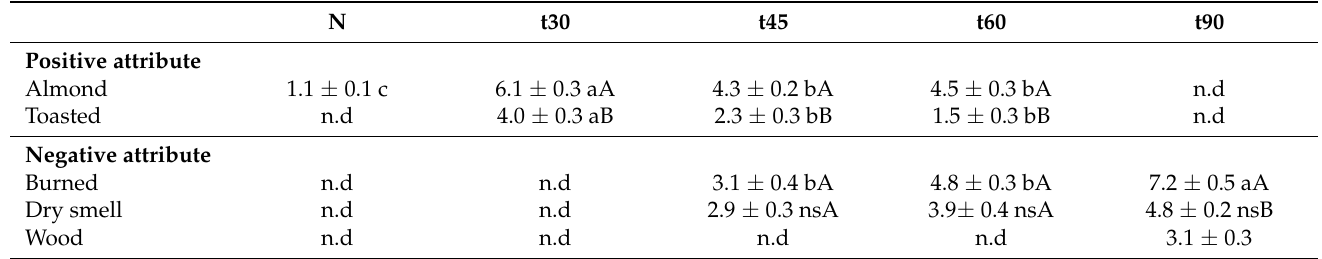
Table 1. Predominantly perceived sensory defects (mean ± standard deviation) of oils from almond seeds subjected to different thermal treatments before oil extraction. Different lowercase letters indicate significant differences between thermal treatments, while capital letters show significant differences between attributes (Tukey’s test, p <